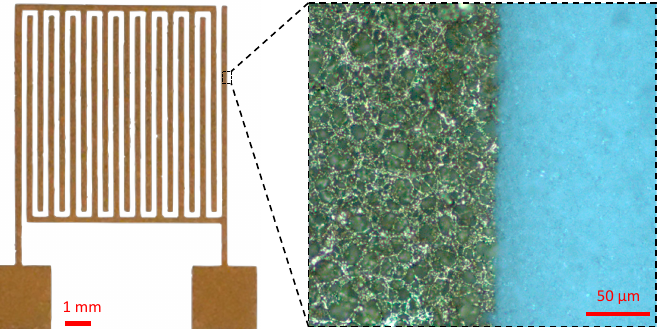
Figure 7. Optical microscopy images of Au-IDE (200 µ m of interdigit gap) deposited on a nitrocellulose membrane. The inset is a zoom in image (magnification 20×) of the electrode showing the Au deposition on the membrane surface as well as in the first microns of the membrane thickness due to NC porosity.